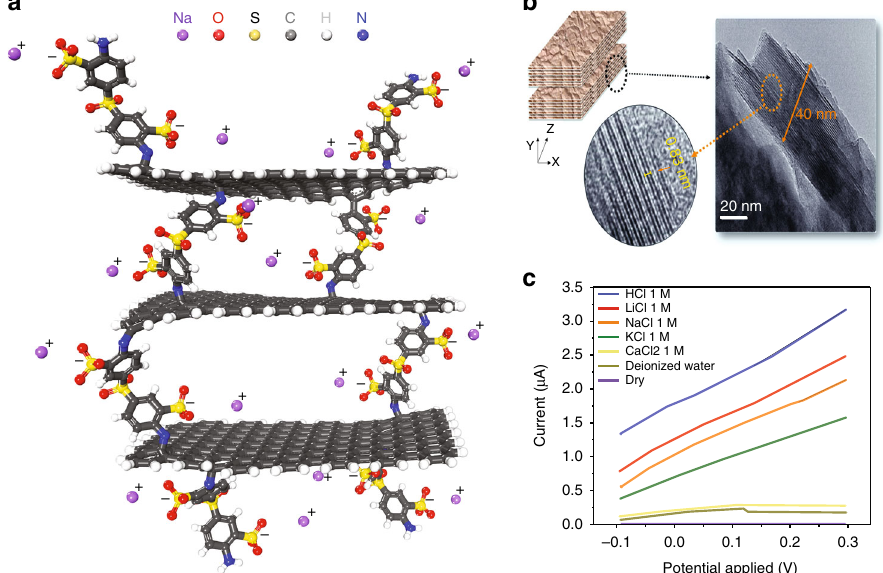
Fig. 6 Effect of nanochannel surface charge on Li-ion selectivity and performance. a Symmetrical multilayer architecture of rGO modi fi ed by grafting of sulfonated 4,4 ′ -diaminodiphenyl sulfone (rGO-SDDS-rGO). The prepared rGO-SDDS-rGO membrane with an average interlayer spacing of ≈ 0.48 nm showed Li + /multivalent cation selectivity (e.g., 5.27 (Li + /Mg 2 + ) and 4.72 (Li + /Ca 2 + )) whereas it exhibited poor Li + /Na + selectivity of 0.84 (the permselectivity of Na + /Li + is 1.19). Reproduced with permission from ref. 56 Copyright 2019 John Wiley and Sons. b 3D model and TEM images (scale bar is 20 nm) of Li + -selective vermiculite membrane. The reassembly of exfoliated vermiculite layers resulted in a Li + selective membrane with 0.43 nm 2D nano fl uidic channels. The membrane exhibited a high Li + conductivity with surface charge-governed ion conductivity in the order of Li + > Na + > K + , and with selectivity ratios of 1.26 for Li + /Na + , 1.59 for Li + /K + , and 1.36 for Na + /K + . The graph in c shows I – V curves of different electrolytic solutions indicating selective transportation of monovalent cations inside the vermiculite membrane, reproduced from refs. 52,62